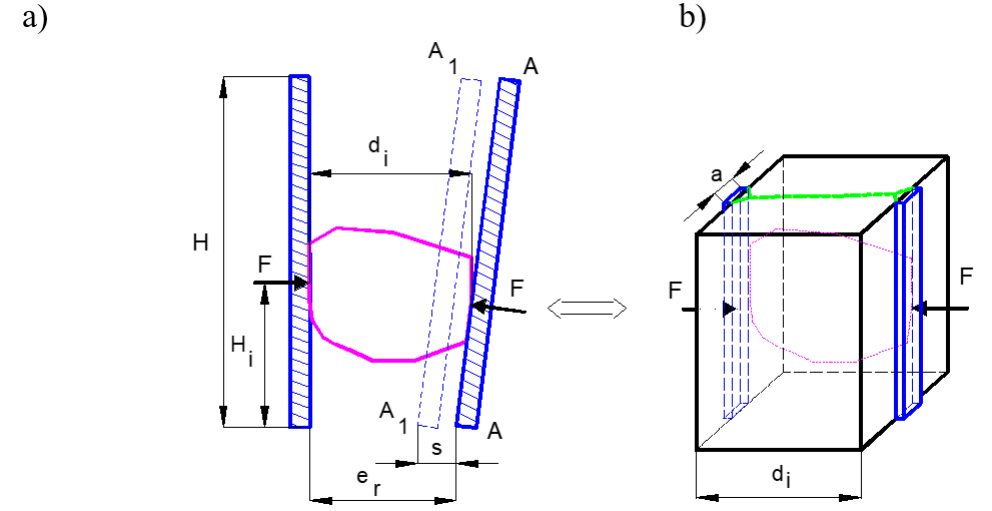
Figure 3: The crushing process in the space of the jaw crusher a) compression in jaw crusher, b) elementary case of the crushing modeling – compressing the rock block between flat